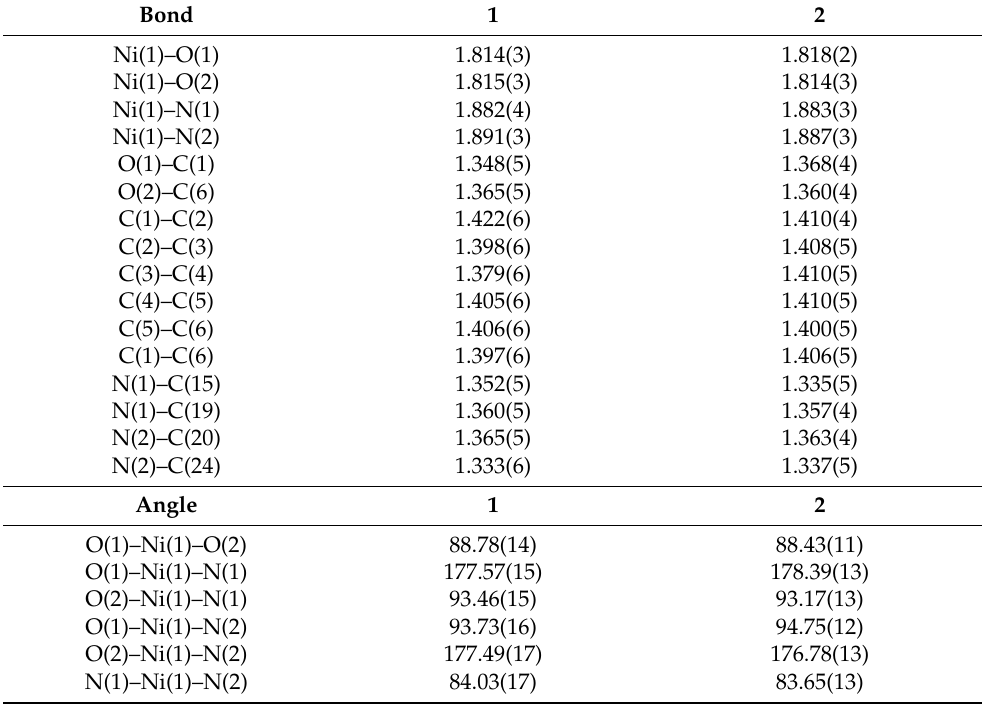
Table 1. Selected bond lengths (Å) and angles ( ◦ ) for 1 and 2 .